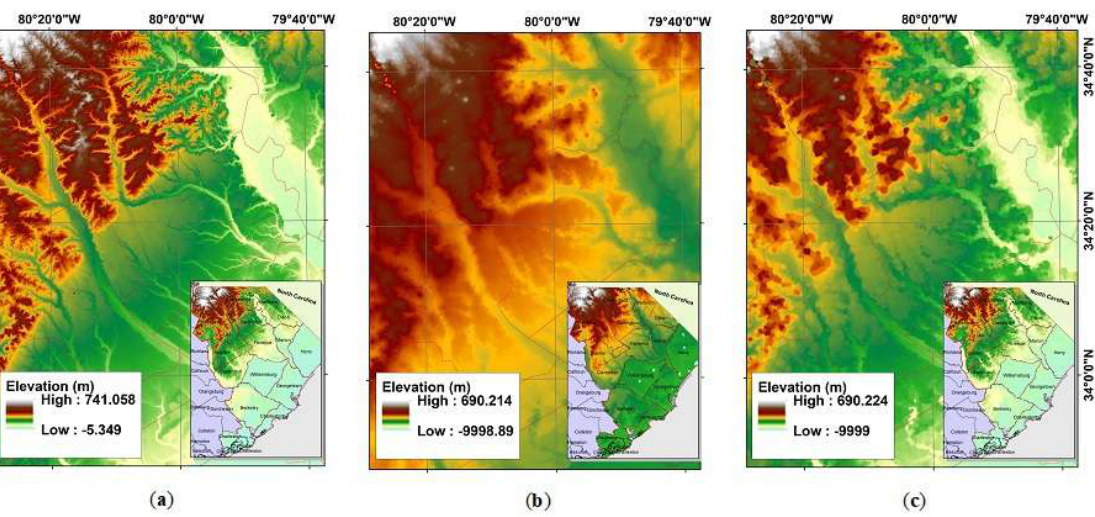
Figure 4. ArcGIS model builder schematics for inverse distance weighting (IDW) generated floodplain.